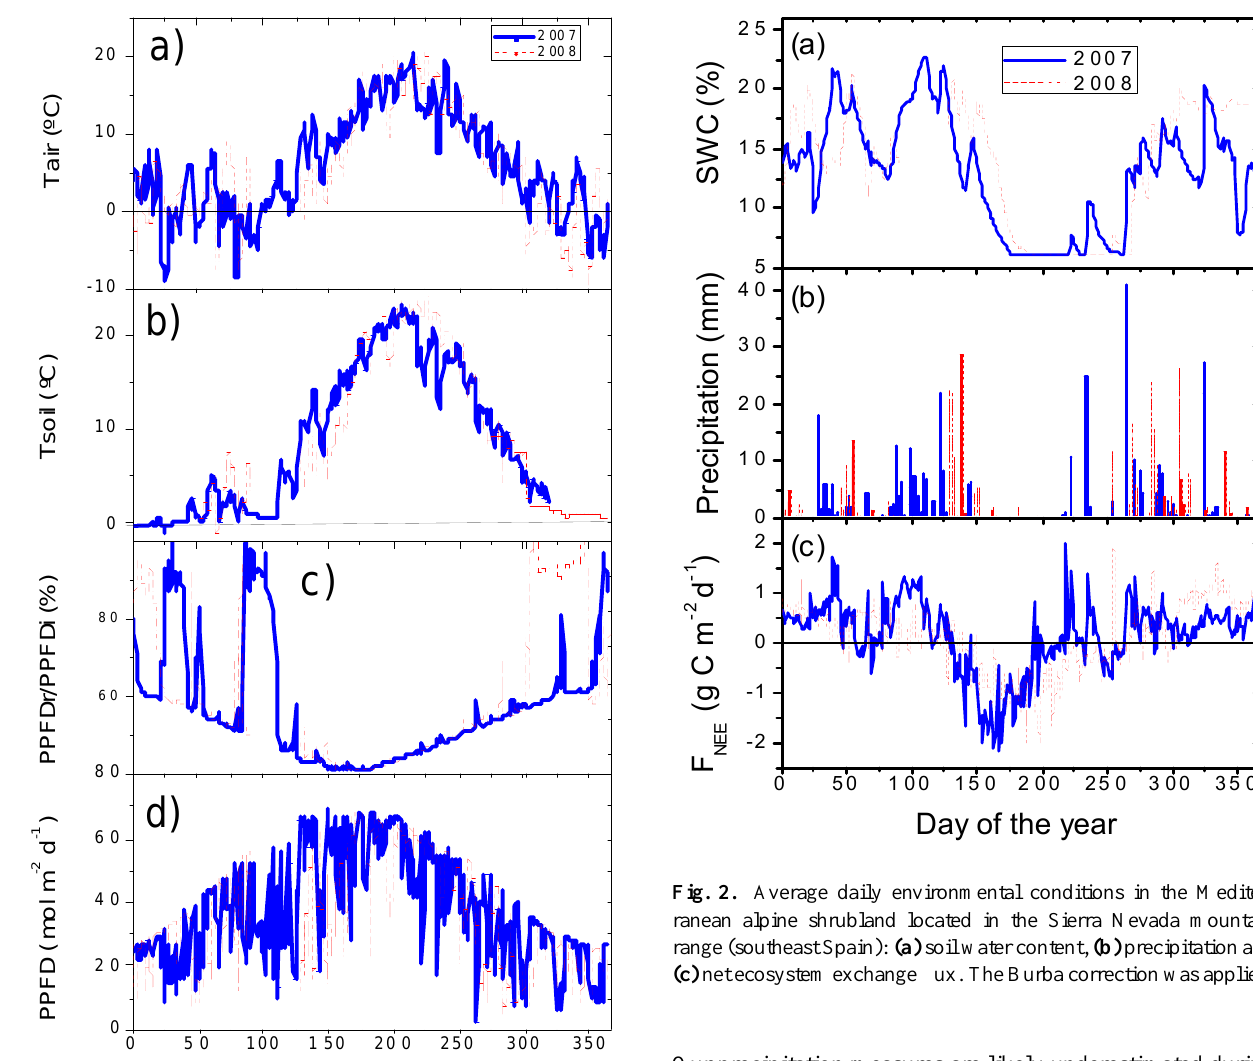
precipitation and (c) net ecosystem exchange flux. The Burba correction was applied.